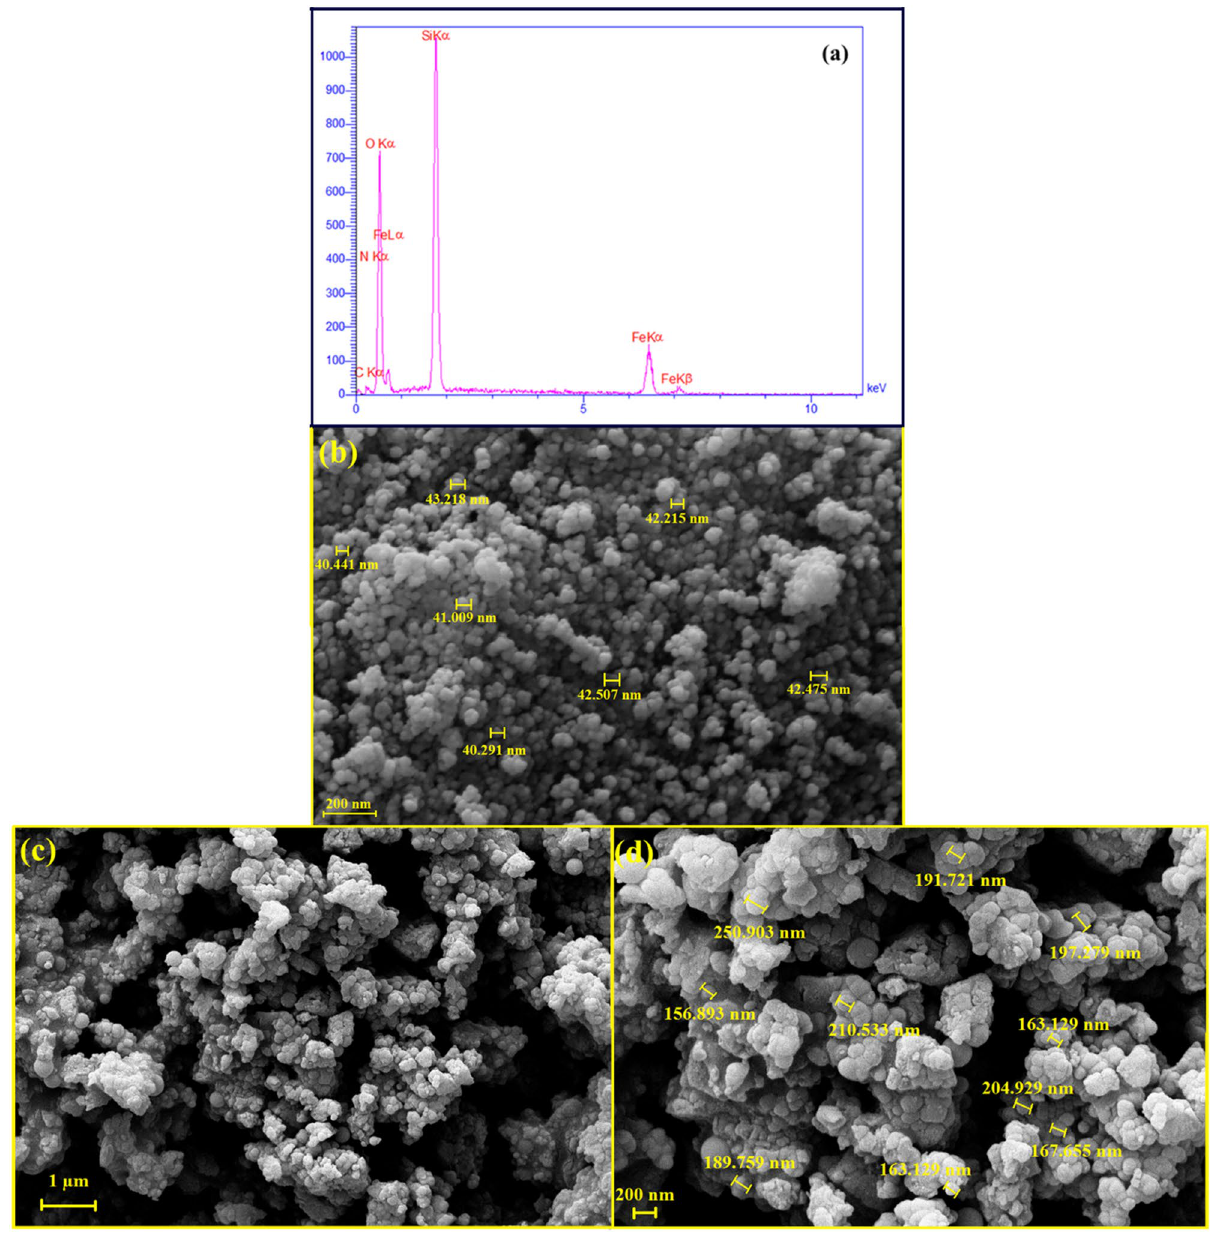
Figure 3. ( a ) EDX spectrum and FE-SEM images of ( b ) Fe 3 O 4 @SiO 2 MNPs and ( c , d ) magnetic Fe 3 O 4 @SiO 2 @ CPTMS@DA